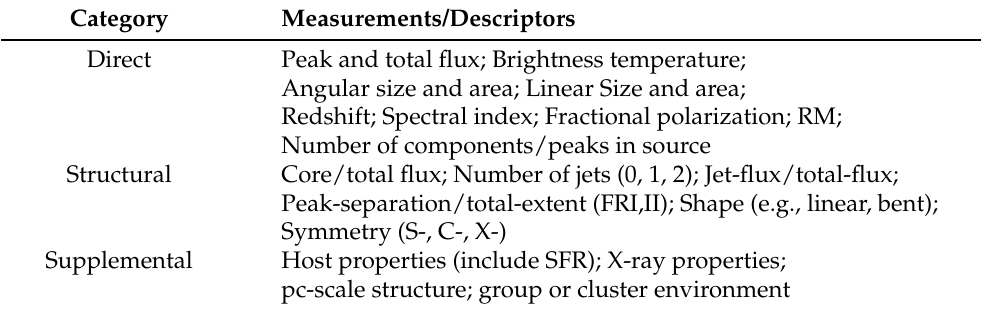
Table 2. Commonly mentioned priorities for catalog source descriptions. These assume that components have been assembled into sources . Some require information external to the